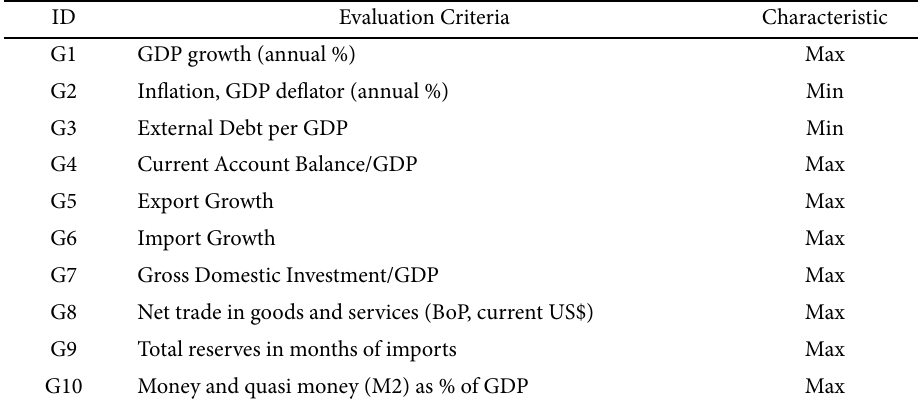
table 2. Evaluation